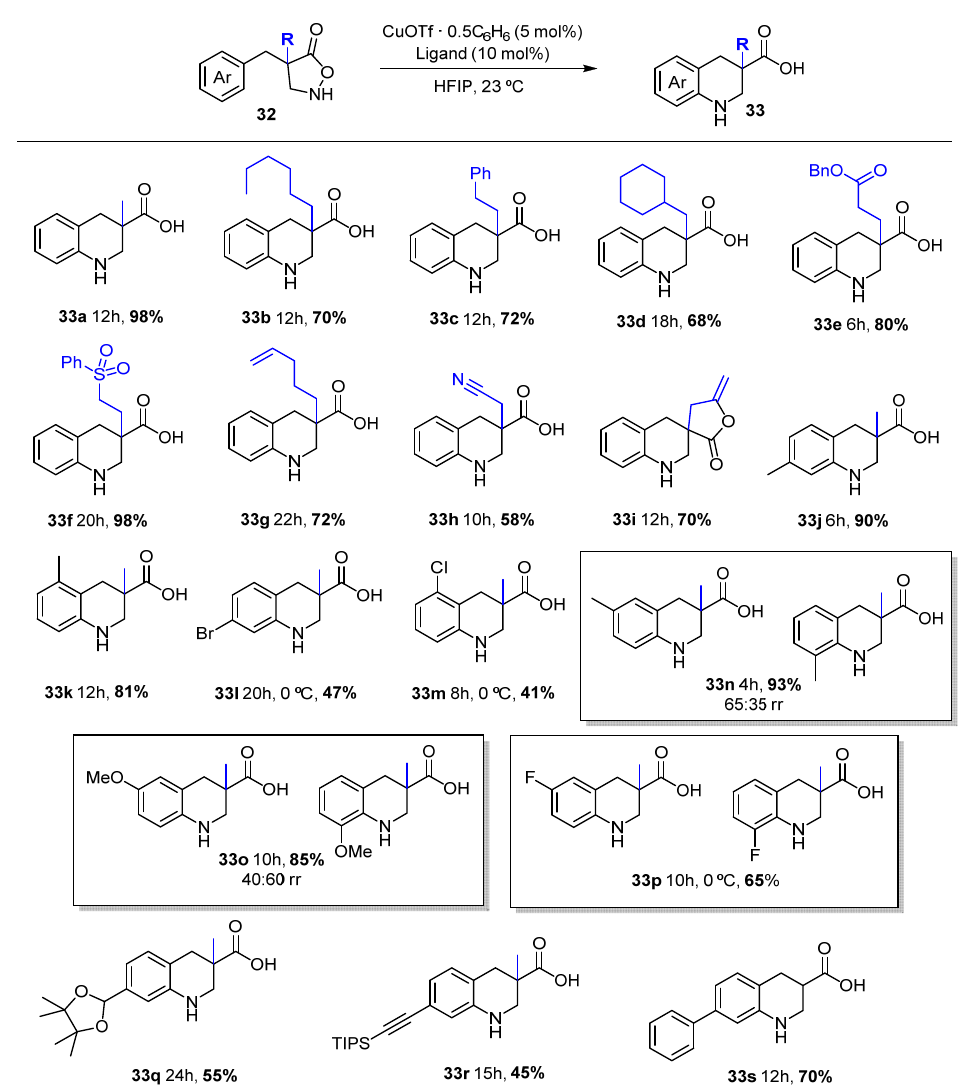
13 of 21 Figure 4. Retrosynthetic analysis proposed for the formation of myeloid cell leukemia-1 (Mcl-1) inhibitor. The optimal conditions of the copper catalyst were carefully studied, and the